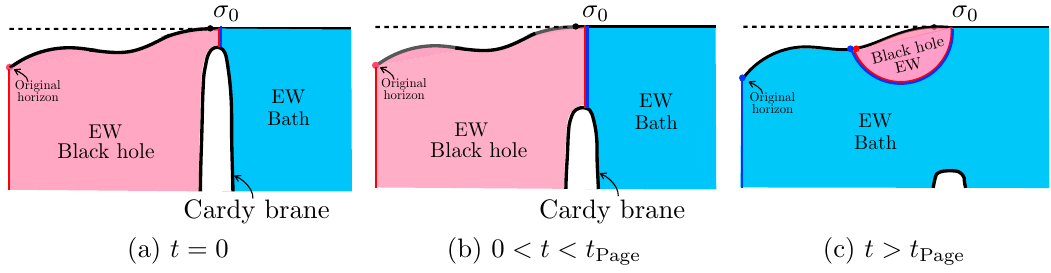
Figure 9 . We show the pro(cid:12)le of the simple boundary brane in the bulk at t = 0. At later times it falls in, in the sense that the physical distance to the boundary increases. We have also shown the black hole entanglement wedges. Where we assumed we started from a black hole at low temperature where the initial horizon is located where we indicated. The pink region is the entanglement wedge of the black hole, while the complementary blue region is the entanglement wedge of the